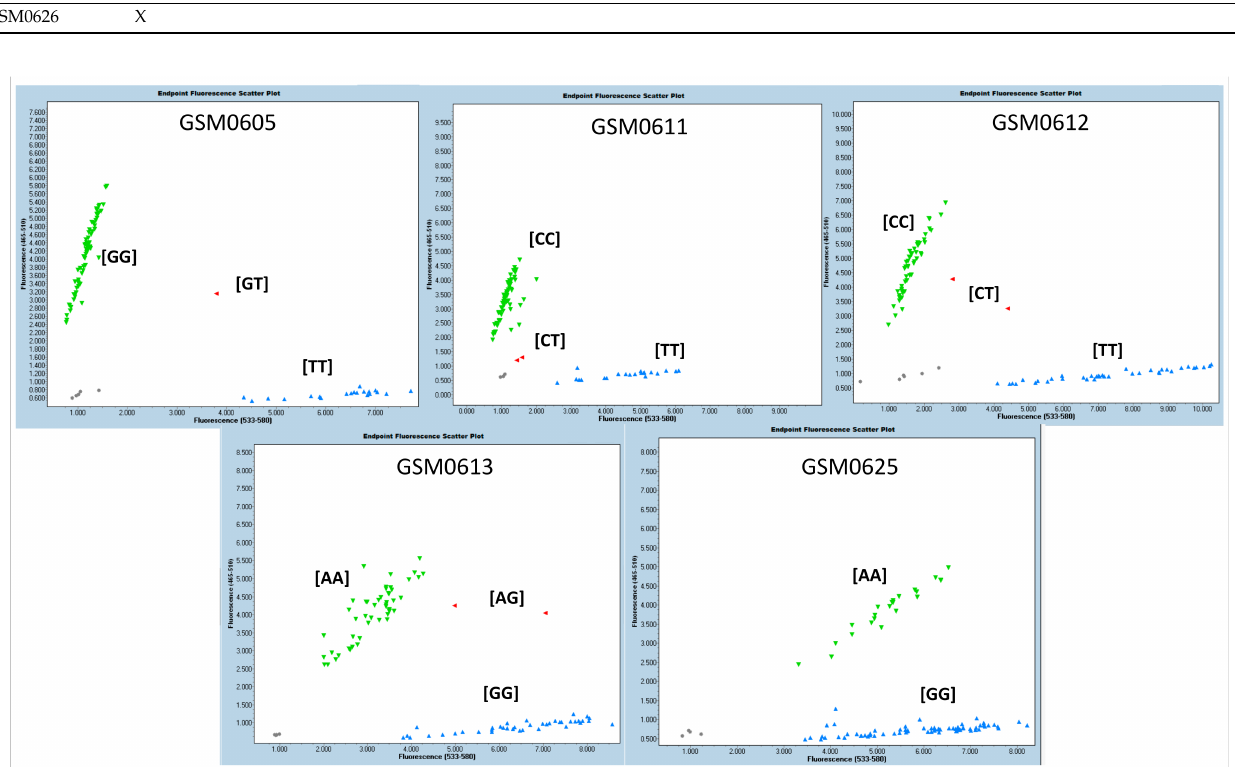
Figure 2. Genotyping plot of KASP assays for GSM0605, GSM0611, GSM0612, GSM0613 and